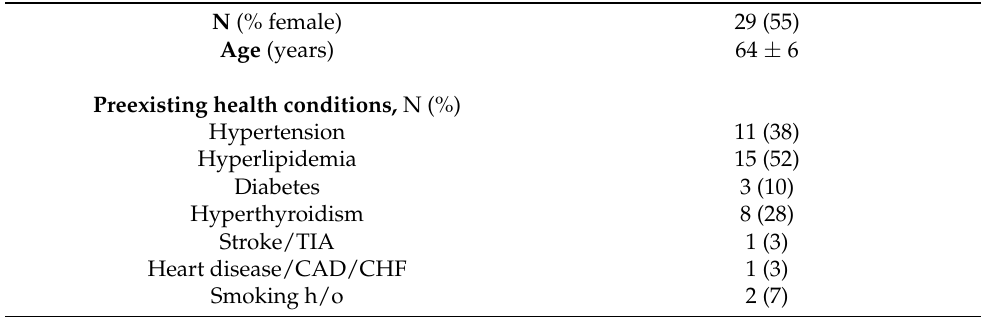
Table 1. Demographics and medical history of subjects in the combined retinal vascular and retinal amyloid analysis.